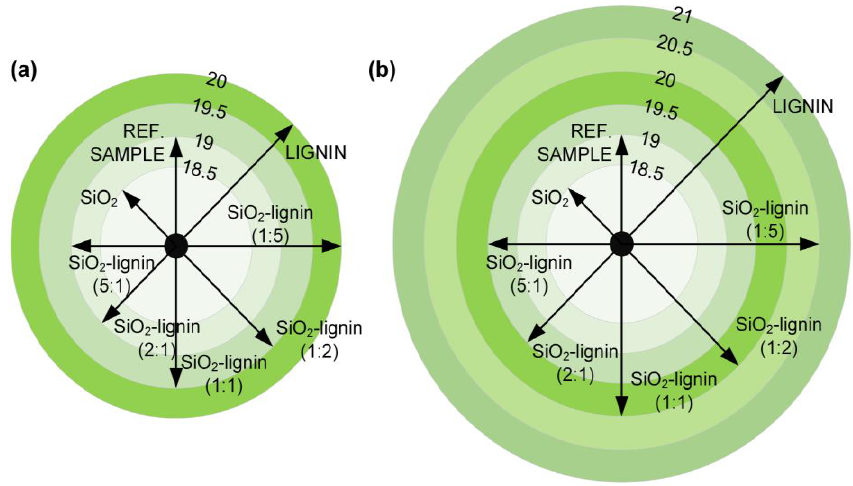
Figure 5. Slump test results for the samples containing 0.5 wt.% ( a ) and 1.0 wt.% ( b ) admixture.